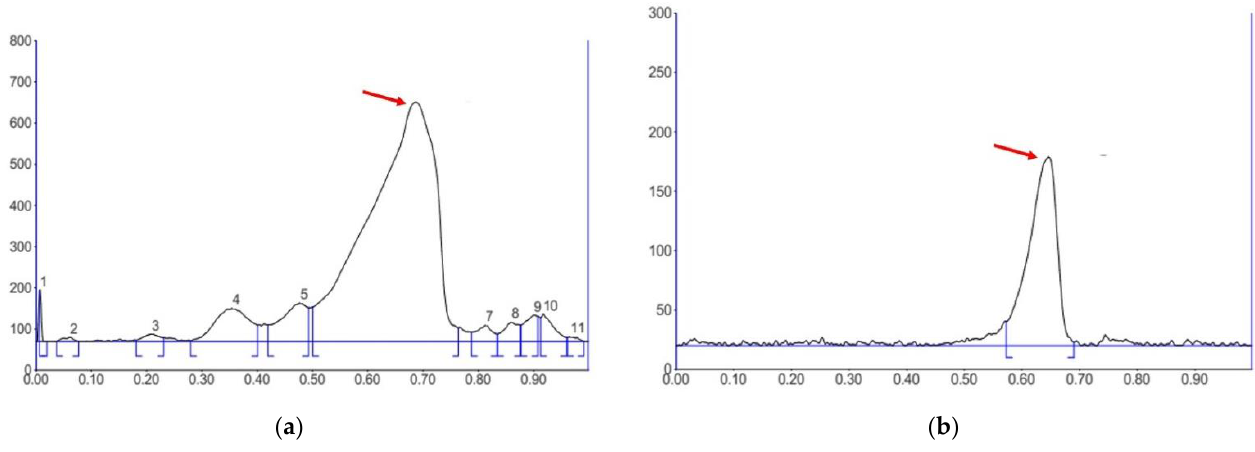
Figure 2. Quantification of brazilin in CSW ethanolic extract using TLC-densitometry analysis. Chromatograms of the CSW ethanolic extract ( a ) and brazilin standard ( b ) were obtained at a detection wavelength of 508 nm. A brazilin peak (red arrow) was observed with a maximum retention factor of 0.69. TLC-densitometry was conducted on silica gel F 254 as the stationary phase with chloroform:acetone:formic acid (4:2:0.5, v / v ) as the mobile phase.